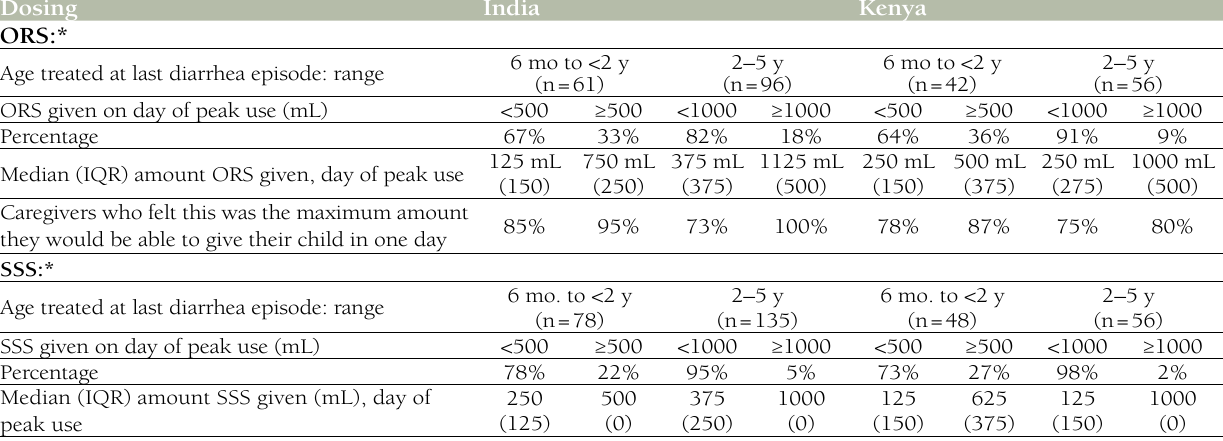
Table 6. Dosing at last episode of diarrhea, ORS and SSS